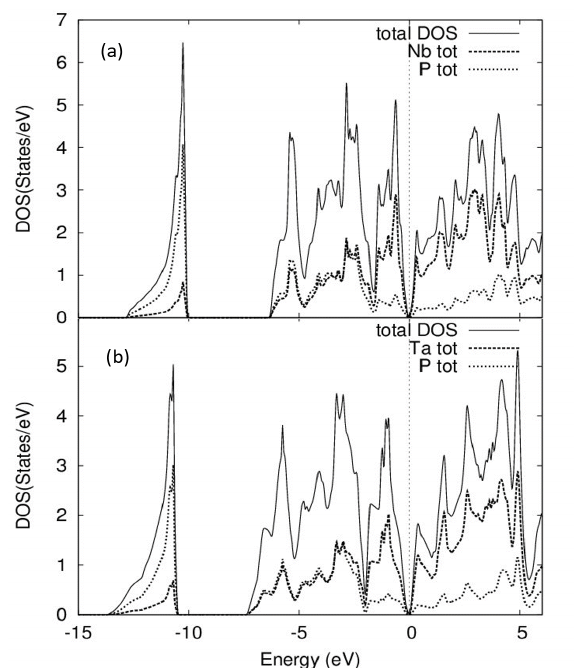
Figure 8. Non-spin polarised electronic density of states of ( a ) NbP and ( b ) TaP including